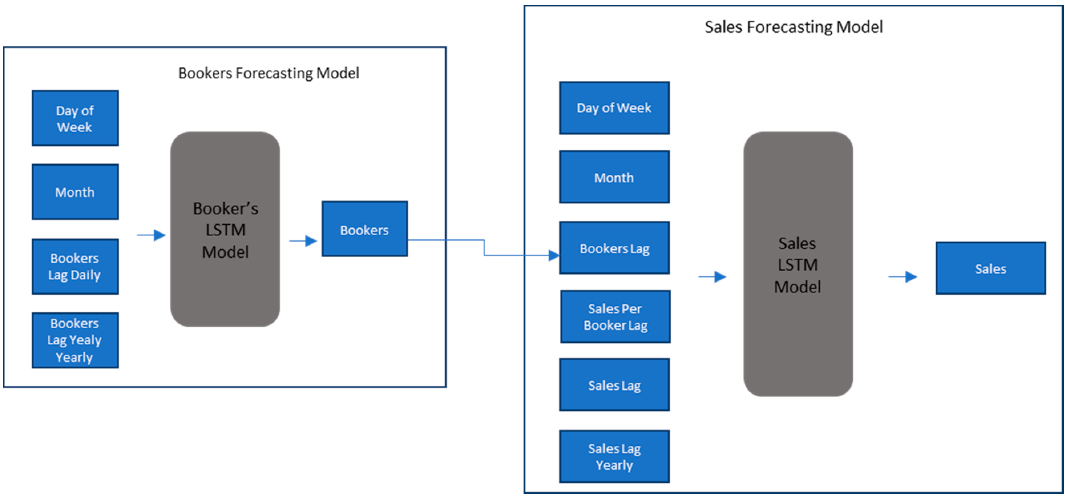
Figure 2. Active Booker Count and Sales forecasting models and the relationship between the two.